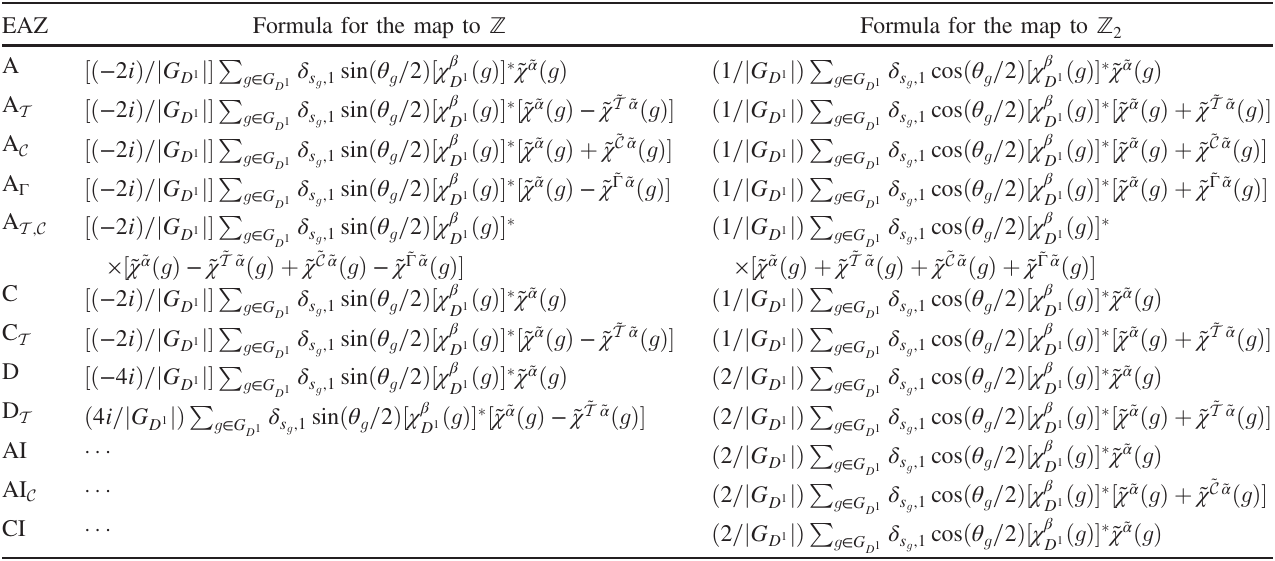
TABLE IV. Formulas to obtain elements of E 1 ; 0 1 corresponding to generating Dirac Hamiltonians. Here, χ α and ˜ χ ˜ α are characters of the ˜ G =T and the on-site symmetry group little cogroup G , respectively. The first column represent EAZ classes of irreducible D 1 ˜ T ˜ α ˜ C ˜ α ˜ Γ ˜ α , , and are labels of the time-reversal-, the particle-hole-, and the chiral-symmetry-related representations ˜ u ˜ α . In addition, irreducible representations. Derivations of these formulas are included in Appendix